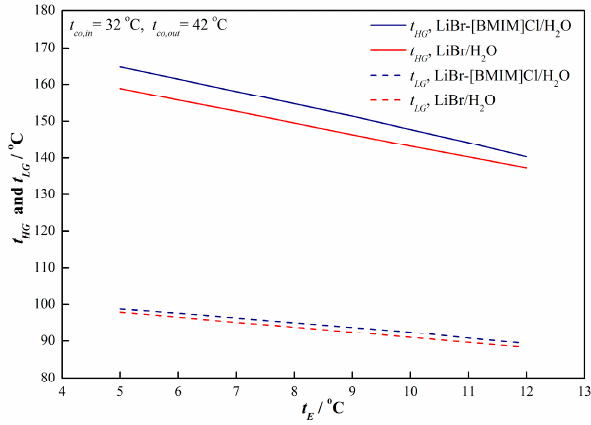
Figure 2. Variations of t HG and t Lg with the evaporation temperature t E .